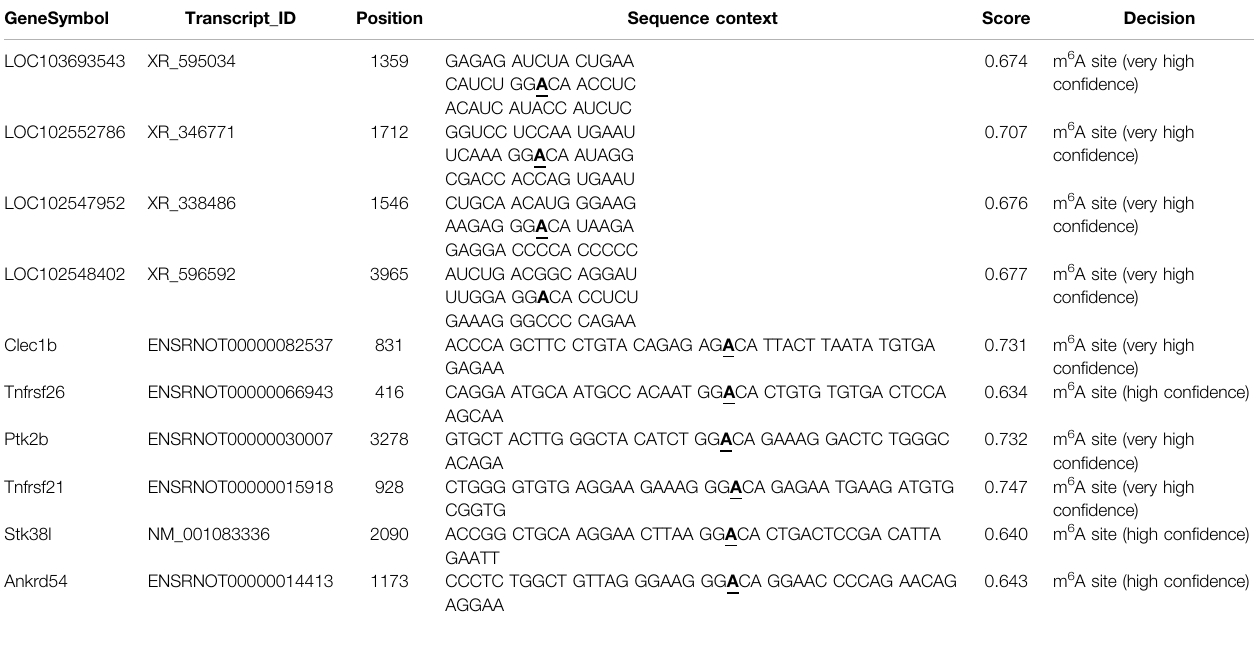
TABLE 5 | Detail information of lncRNAs and mRNAs with hyper- and hypo-methylation detected by m 6 A single-base site